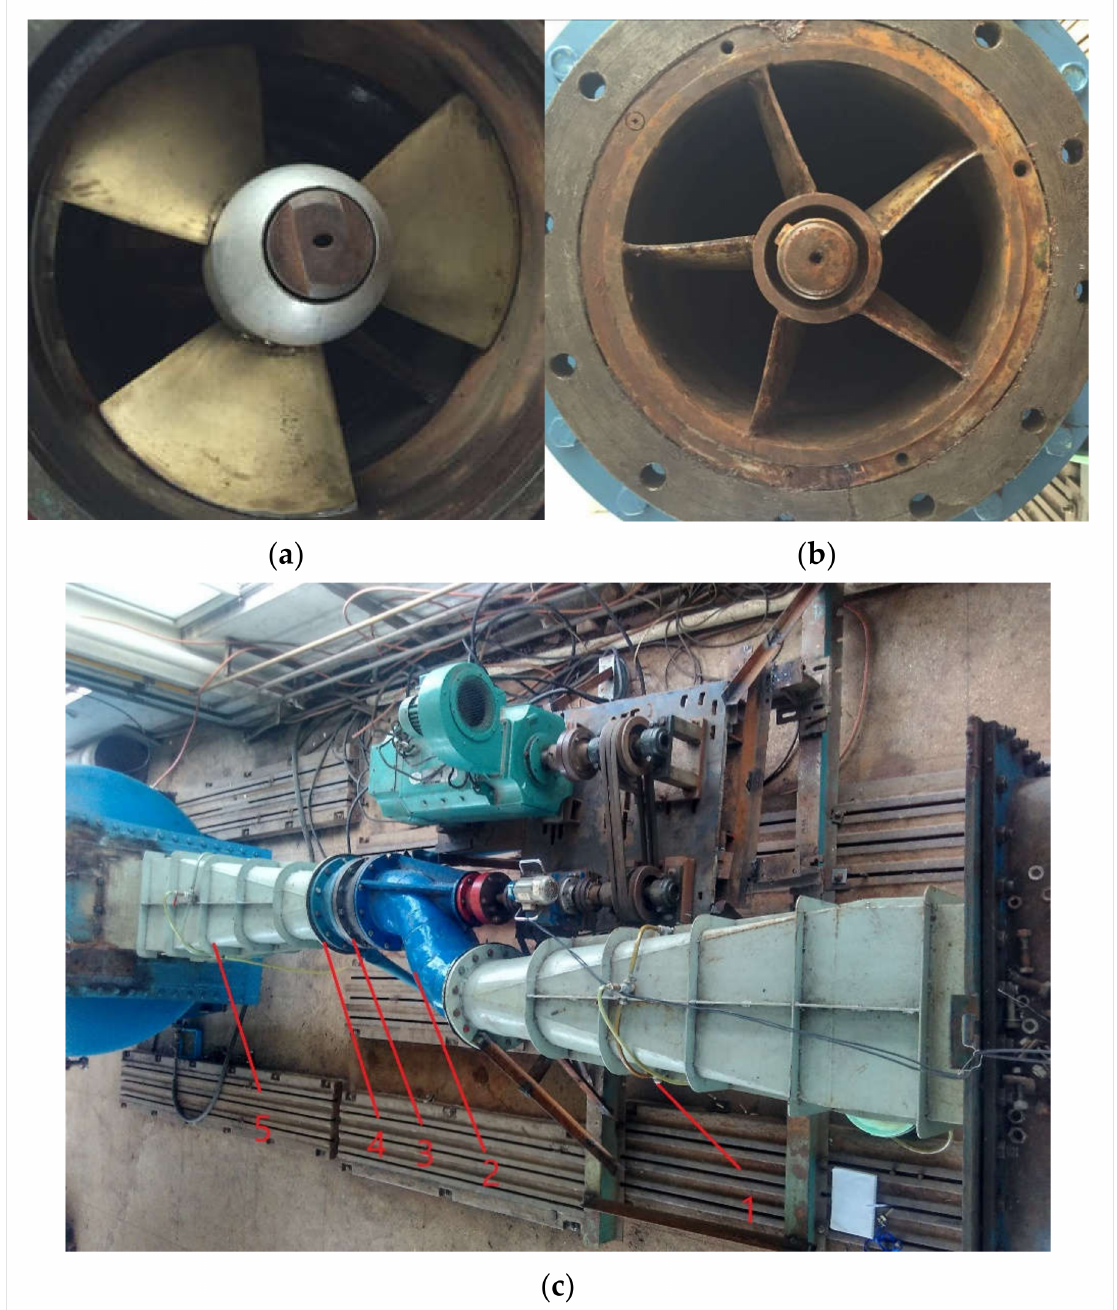
Figure 6. Model pump device. ( a ) Impeller. ( b ) Guide vane. ( c ) Pump device installation. (1). Inlet channel. (2). S-typed elbow pipe. (3). Impeller chamber. (4). Guide vane. (5). Outlet